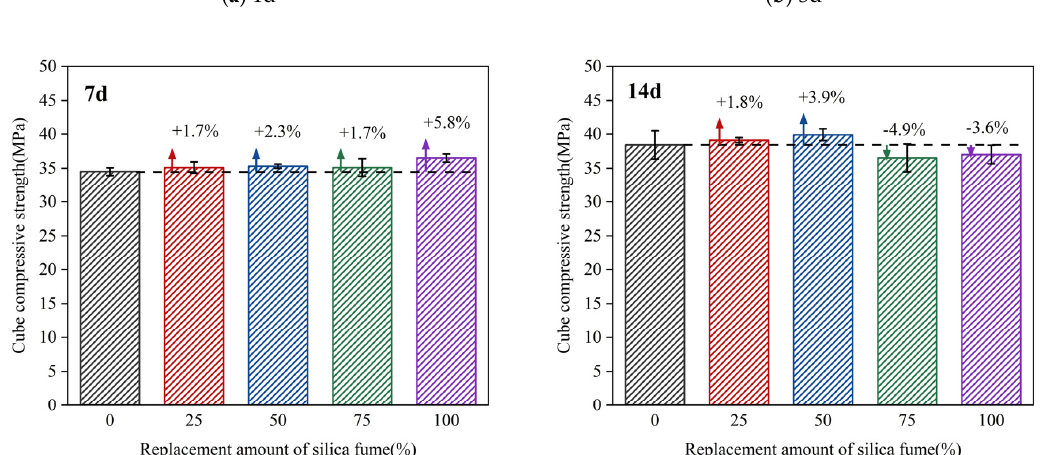
( e ) 28d Figure 6. Comparison of compressive strength of concrete cubes with different replacement amounts of silica fume at different curing ages: ( a ) 1 d; ( b ) 3 d; ( c ) 7 d; ( d ) 14 d; ( e ) 28 d.